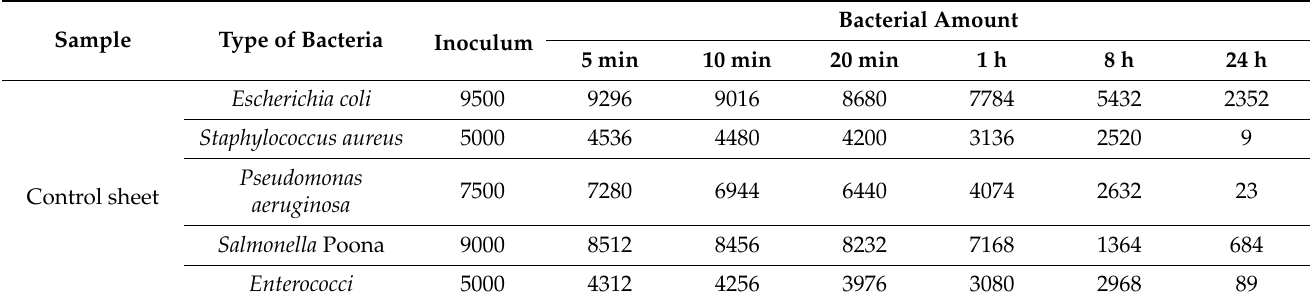
Table 2. Bacterial count on PLA/copper sheet over different time intervals.